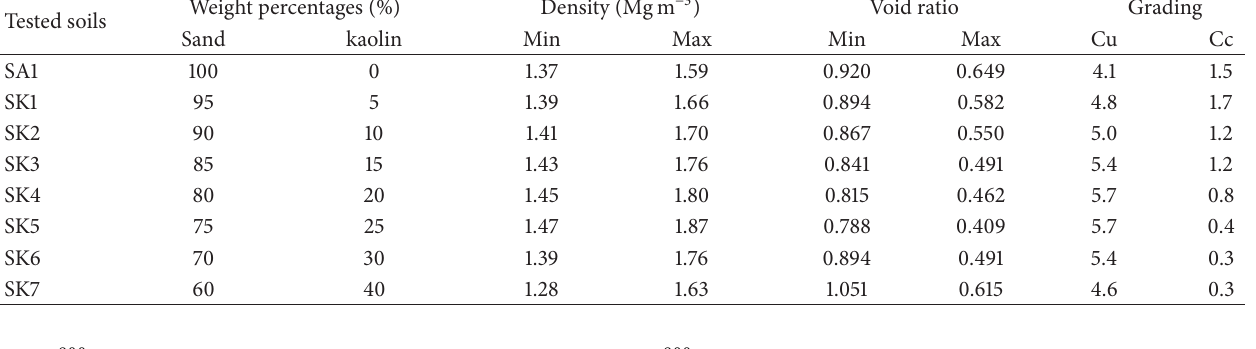
Table 4: Compositional characteristic of tested sand matrix soils.